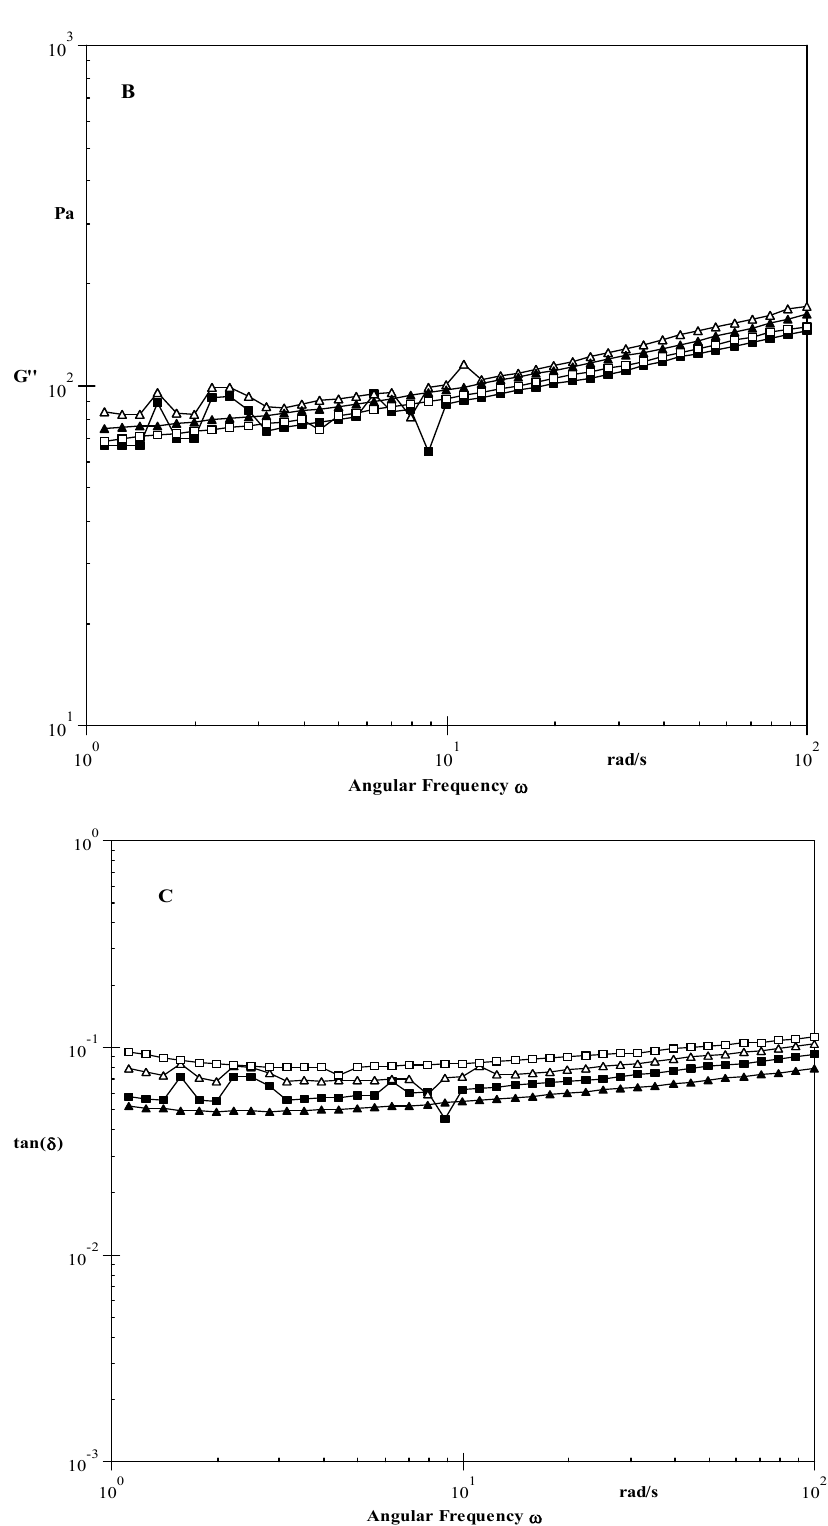
Figure 3. ( A ) Angular frequency dependence of G ′ at 25 °C for native and modified starches. ( B ) Angular frequency dependence of G ″ at 25 °C for native and modified starches. ( C ) Angular frequency dependence of tan δ at 25 °C for native and modified starches. ▀ —Native starch Δ —HMT □ —Microwave ▲ —Sonication.